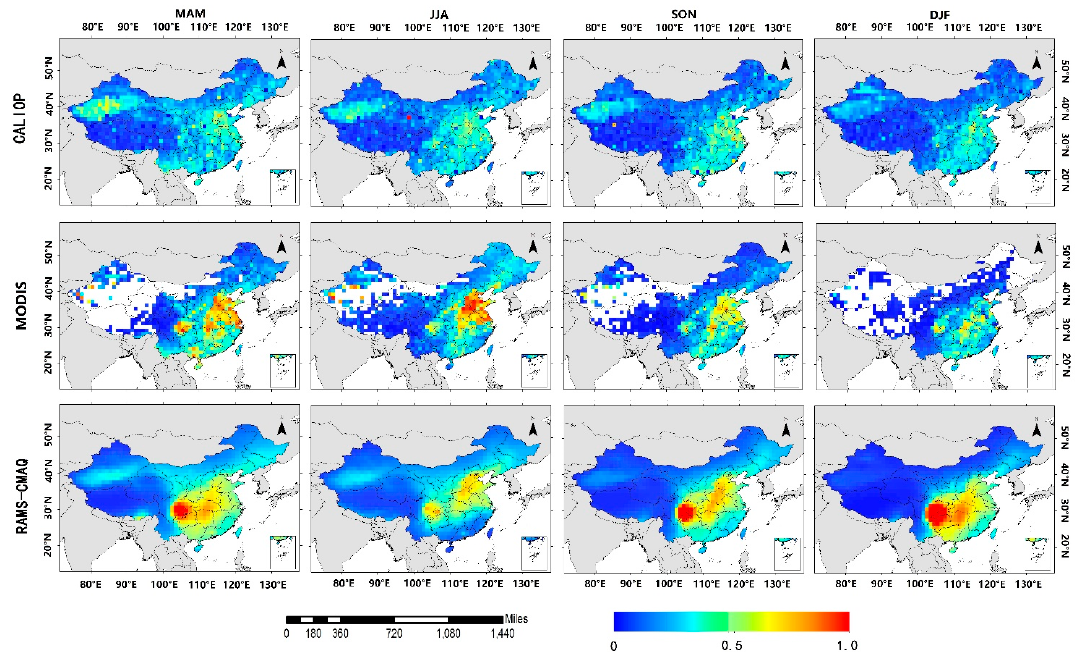
Figure 2. AOD spatial distributions from CALIOP ( top row ), MODIS ( middle row ) and RAMS-CMAQ ( bottom row ) for the four seasons in the wavelengths of 532, 550, and 550 nm, respectively.